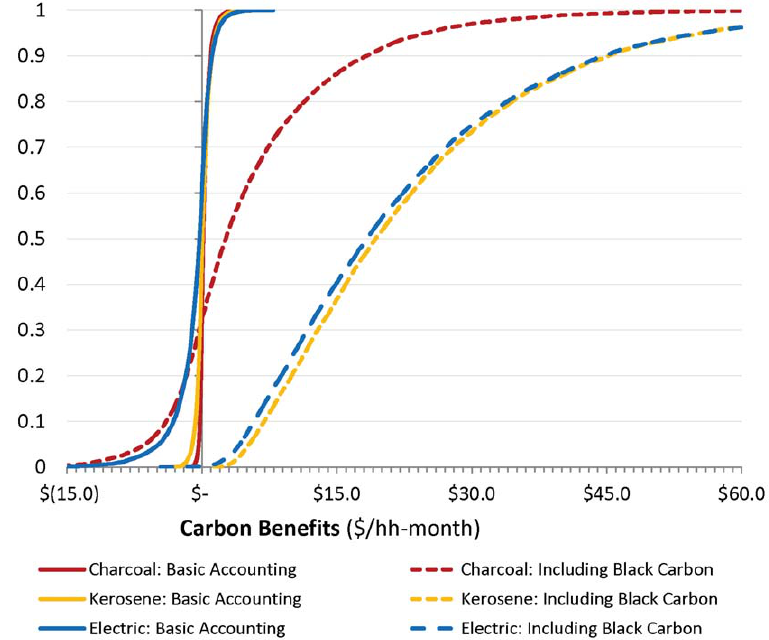
Figure 5. The effect of using different accounting assumptions about emissions from unimproved charcoal, kerosene and electric stove (measured relative to traditional wood-burning stoves). Basic accounting includes only CO 2 , CH 4 and N 2 O; the other also includes CO, NMHC and black carbon. doi:10.1371/journal.pone.0030338.g005 PLoS ONE |